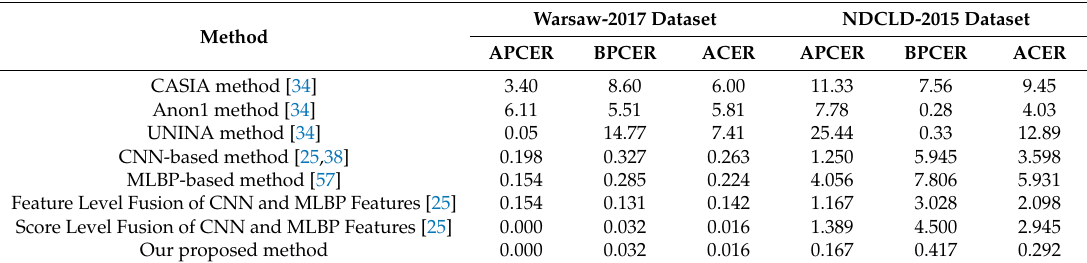
Table 14. Comparison of detection errors (ACER) between proposed method and previous methods using Warsaw-2017 and NDCLD-2015 datasets (unit: